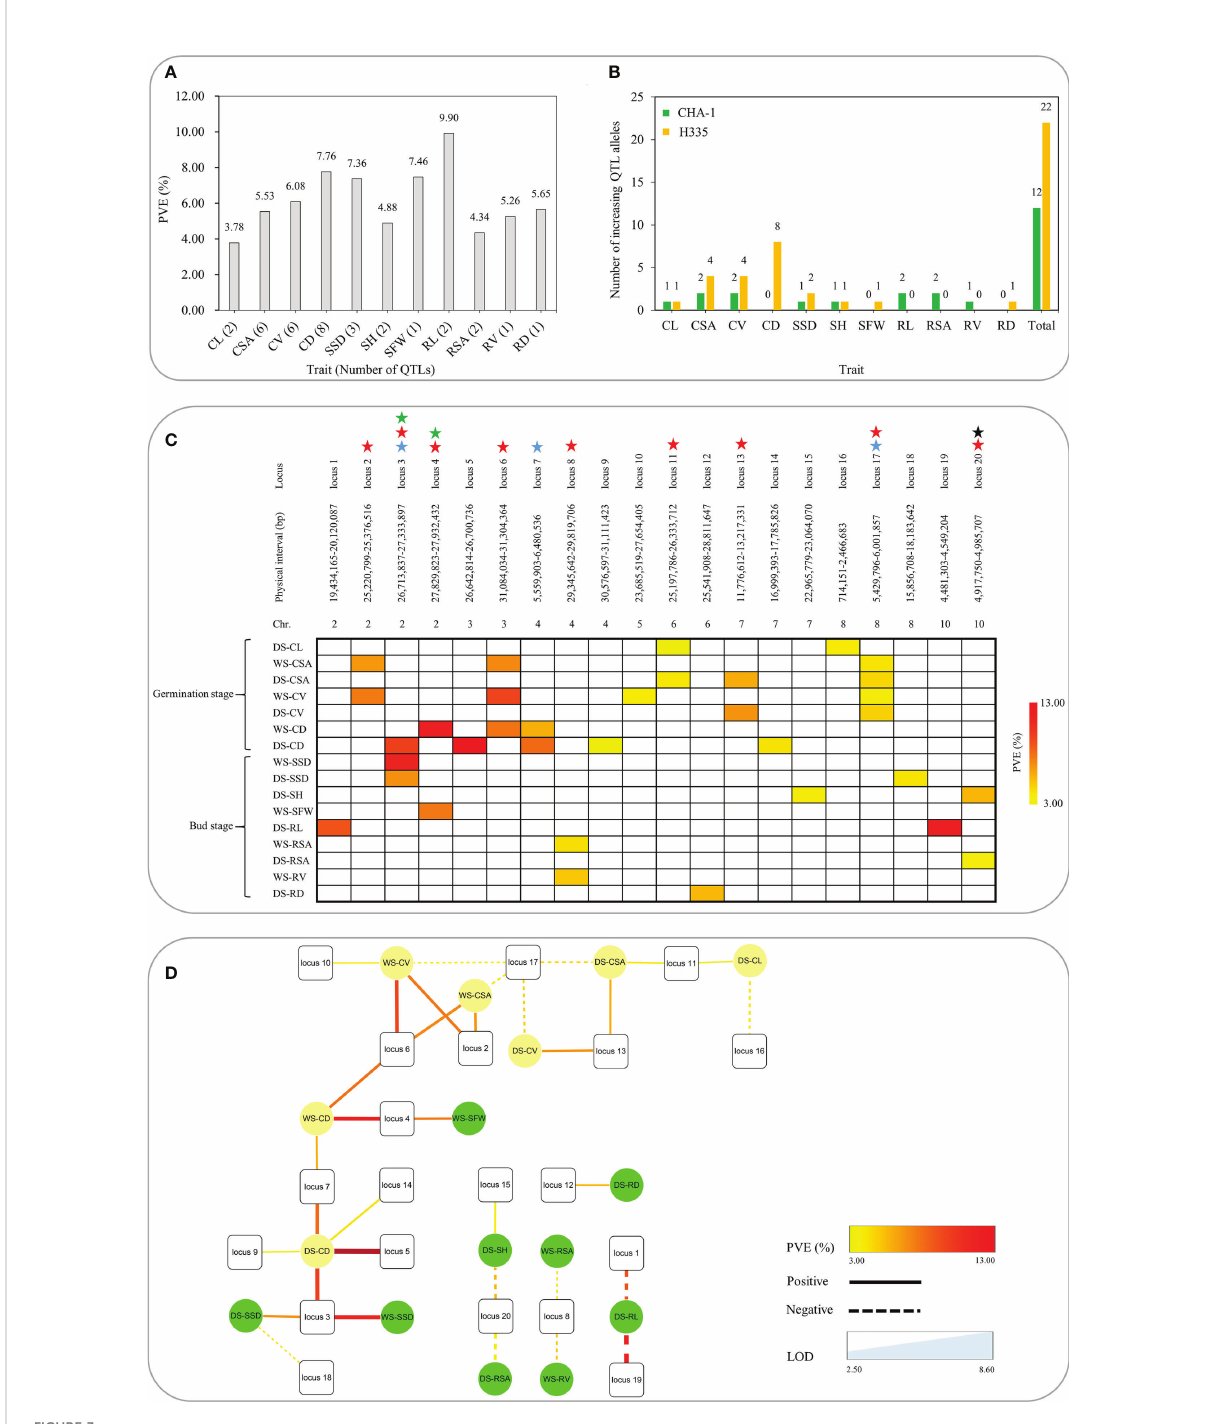
FIGURE 3 Summary of 20 loci associated with 11 traits related to anaerobic tolerance. (A) Phenotypic contribution rates of QTLs associated with 11 traits. (B) Number of increasing QTL alleles in various traits contributed by parents. (C) Heat map reveals pleiotropy of various QTLs. The different colors shown in the legend correspond to various levels of explanation of phenotypic variation. The blue star means detected in both seasons, the red star represents the simultaneous in fl uence of multiple traits, the black star represents the trait that affects both shoots and roots for bud growth, and the green star indicates that both seed germination and bud growth are affected. (D) The interaction network of different traits and QTLs. The square represents locus, the circle represents trait; the dotted line represents the negative effect, the solid line represents the positive effect; the thickness of the line represents the LOD value, and the color of the line represents the